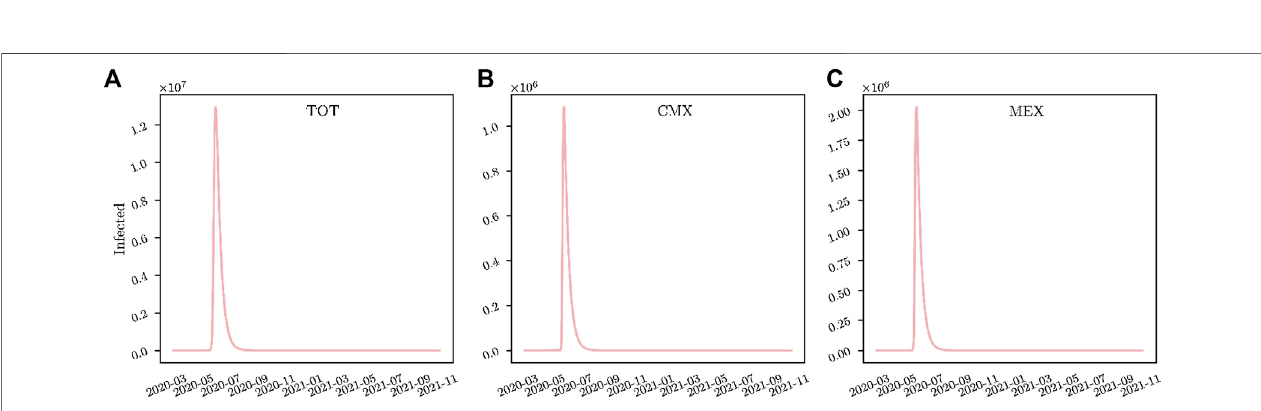
FIGURE 4 | Scenario 2: Completelifting Con fi nement on June 1, 2020. Panels (A) Present a sharp and massive return of people for social decon fi nement on June 1, 2020 for the whole country; (B) CMX, and; (C) MEX, respectively.